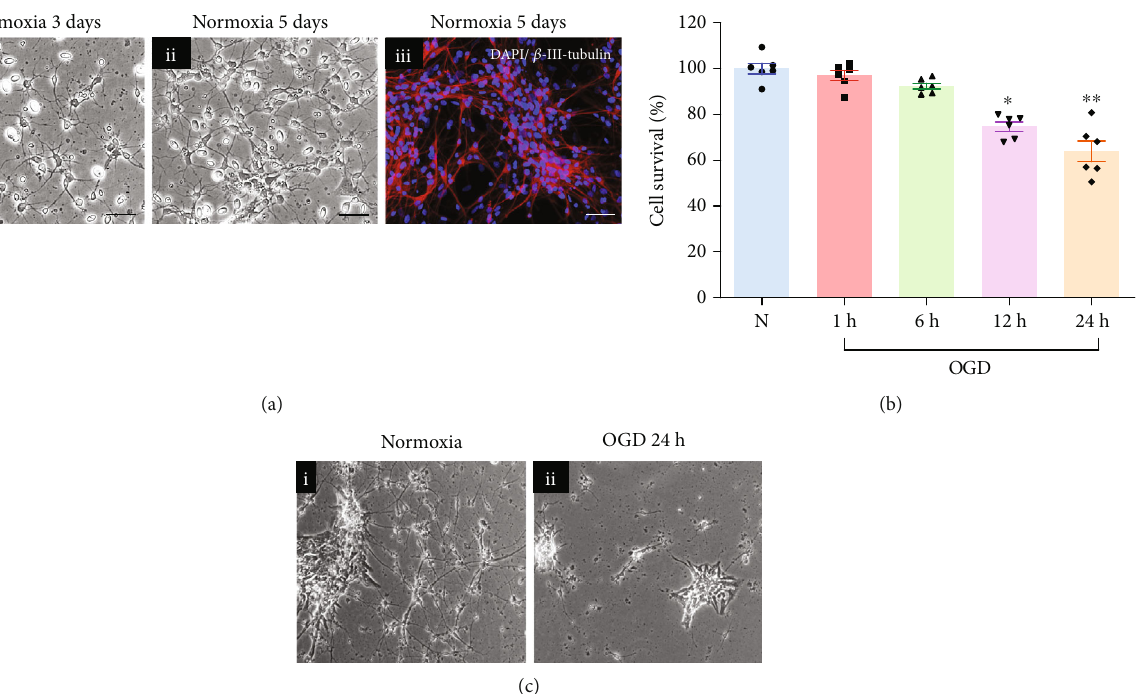
Figure 1: Characterization of hippocampal primary cell cultures and e ff ects of OGD injury. (a) Typical morphology of healthy hippocampal primary cell cultures from chick embryos under normoxic conditions. (i) At day 3, neurons were small with round cell bodies and short neurites. (ii) At day 5, neurons showed longer neurites forming extensive neural networks. (iii) Merged immuno fl uorescence images from cultured neurons showing cell bodies stained with DAPI (blue) and neurites with β -III-tubulin (red). Scale bar: 50 μ m. (b) Time course of cell survival during OGD incubation. Cell survival was evaluated by the MTT assay. (c) Representative image from hippocampal cell cultures exposed to either normoxic condition or OGD for 24 h. Scale bar: 10 μ m. Bars represent mean ± SEM . Asterisks ( ∗ ) indicate signi fi cant di ff erences in comparison to the control ( ∗ p < 0 : 05 ; ∗∗ p < 0 : 01 ) as assessed by one-way ANOVA and Tukey as posthoc